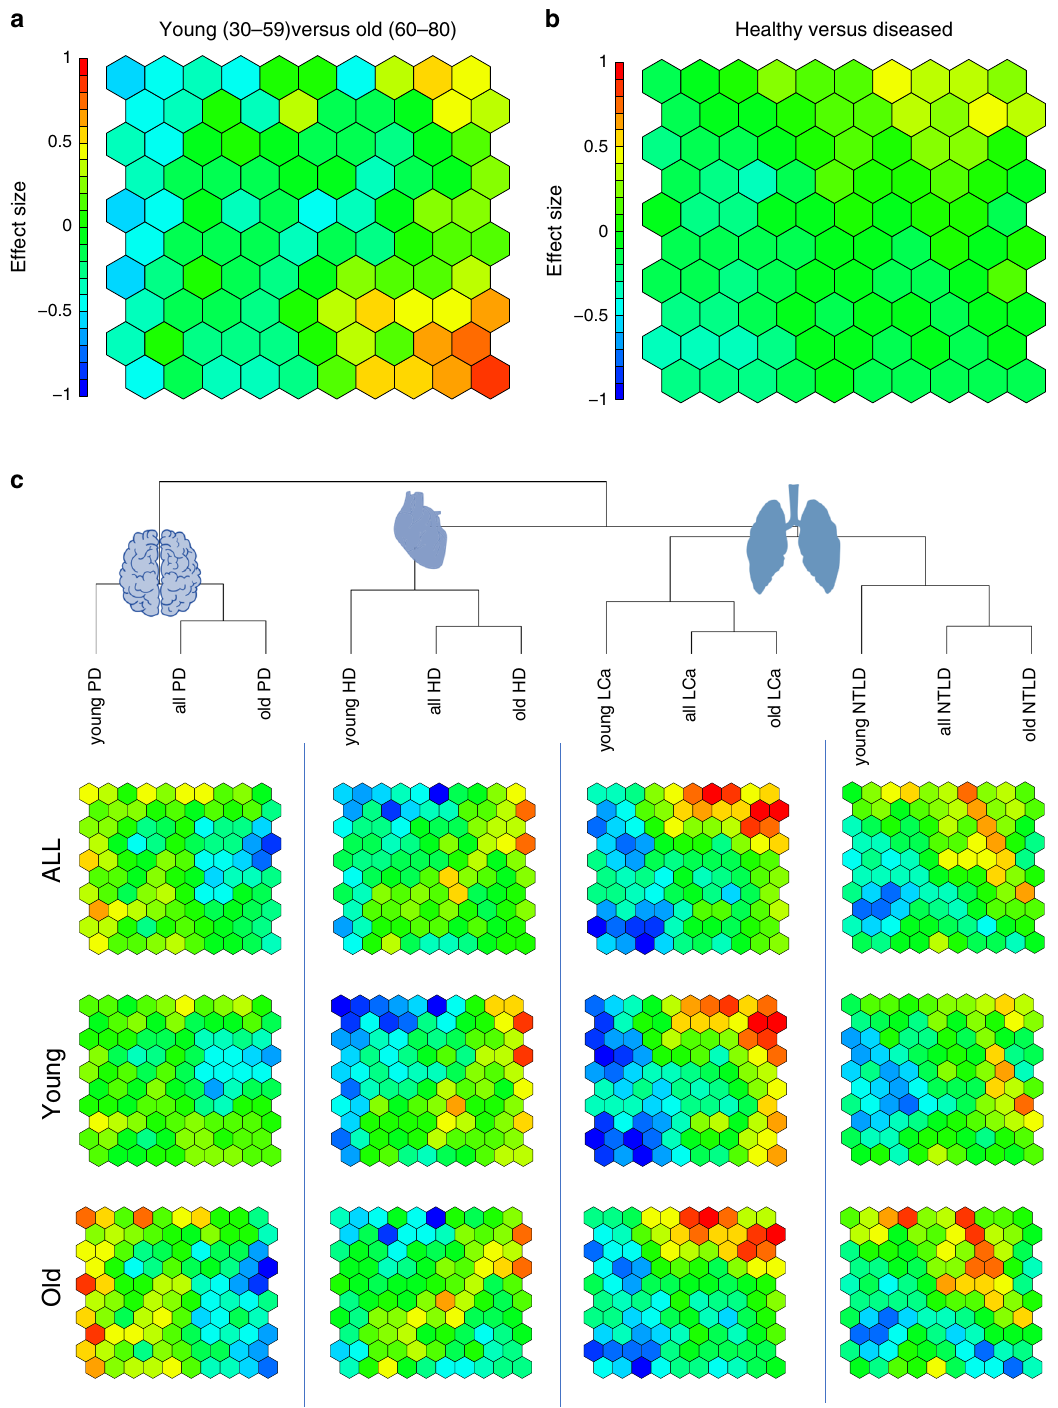
Fig. 4 Disease speci fi city of miRNA biomarkers. a Heat map representation of the SOM analysis as a 10 × 10 grid with 100 entries. Each cell contains at least one miRNA and up to 20 miRNAs. The full annotation of miRNAs to cells are provided in Supplementary Data 7). The cells are colored by the effect size of miRNAs for the comparison in old versus young. Red cells contain miRNAs with effect sizes >0.5 that are upregulated and in blue miRNAs that are downregulated with effect sizes < − 0.5. b Same heat map as in a but colored for the difference in young versus old. The scale for the effect size has been kept the same as a . Thus fewer yellow/red, as well as blue spots indicate overall lower effect sizes. c Clustering of the SOM results in biomarkers for the four diseases and in all biomarkers independently of age, biomarkers for young patients and biomarker for old patients. The dendrogram has been computed from hierarchical clustering (complete linkage on the Euclidean distance). In all cases the biomarkers cluster by disease and not by age and the old biomarker set is closest to the all biomarker set while the young biomarker set has larger distances. Overall, NTLD and LCa markers are closest to each other, second closest are heart biomarkers and most different PD biomarkers. The SOM cells clearly highlight differences between biomarkers for diseases in young and old